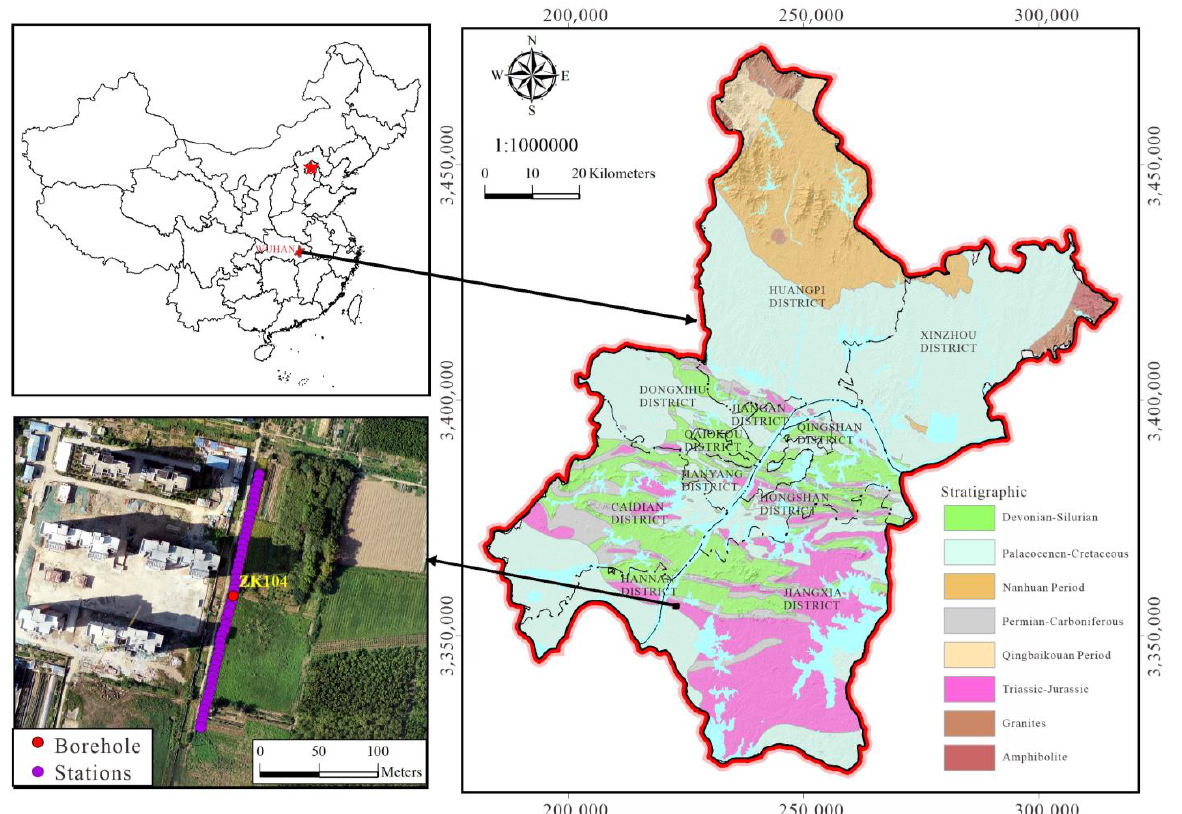
Figure 3. The geological map and location of survey lines in the study area.